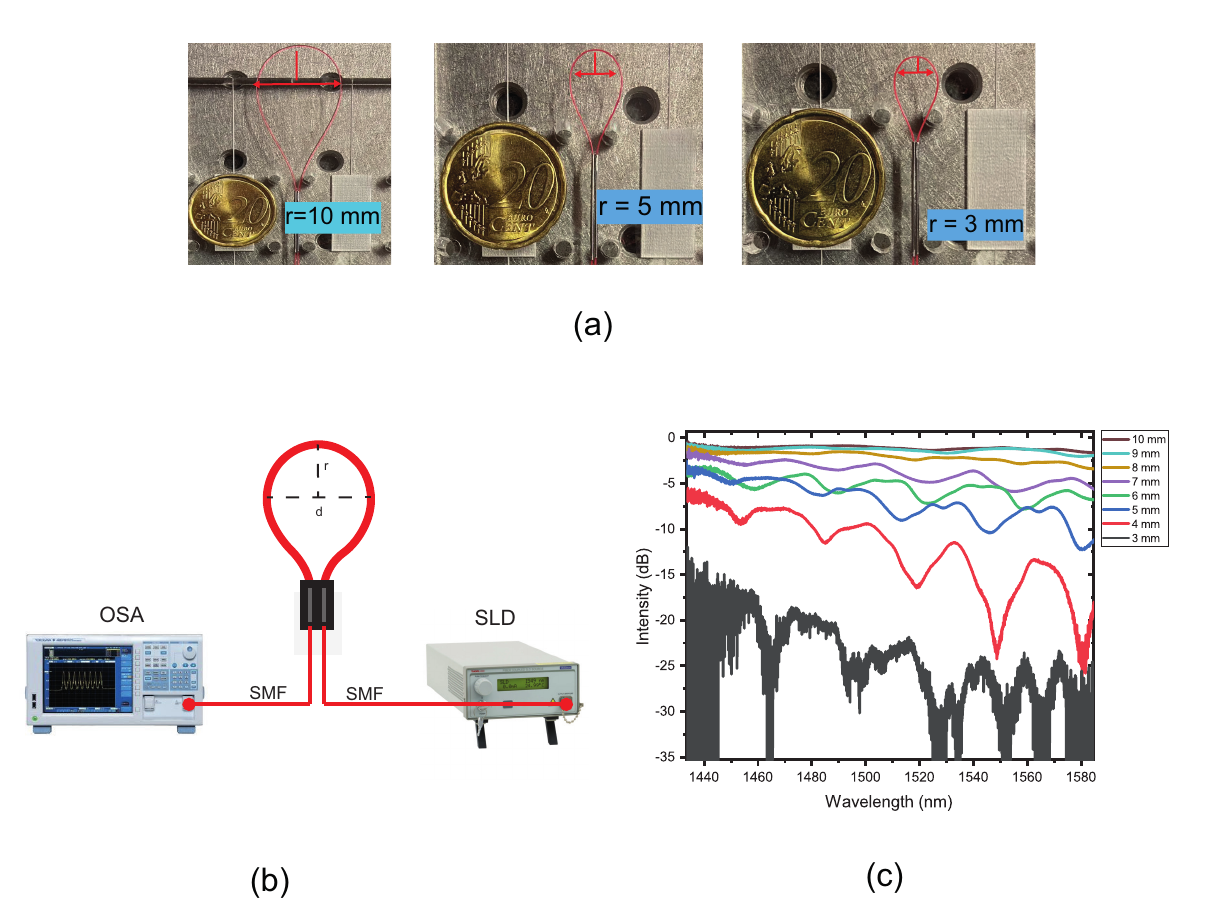
Figure 2. ( a ) Balloon-like interferometer with different lengths and radii of curvature; ( b ) Trans- mitted spectrum for different values of radius of curvature. ( c ) Proposed setup to balloon-like interferometer